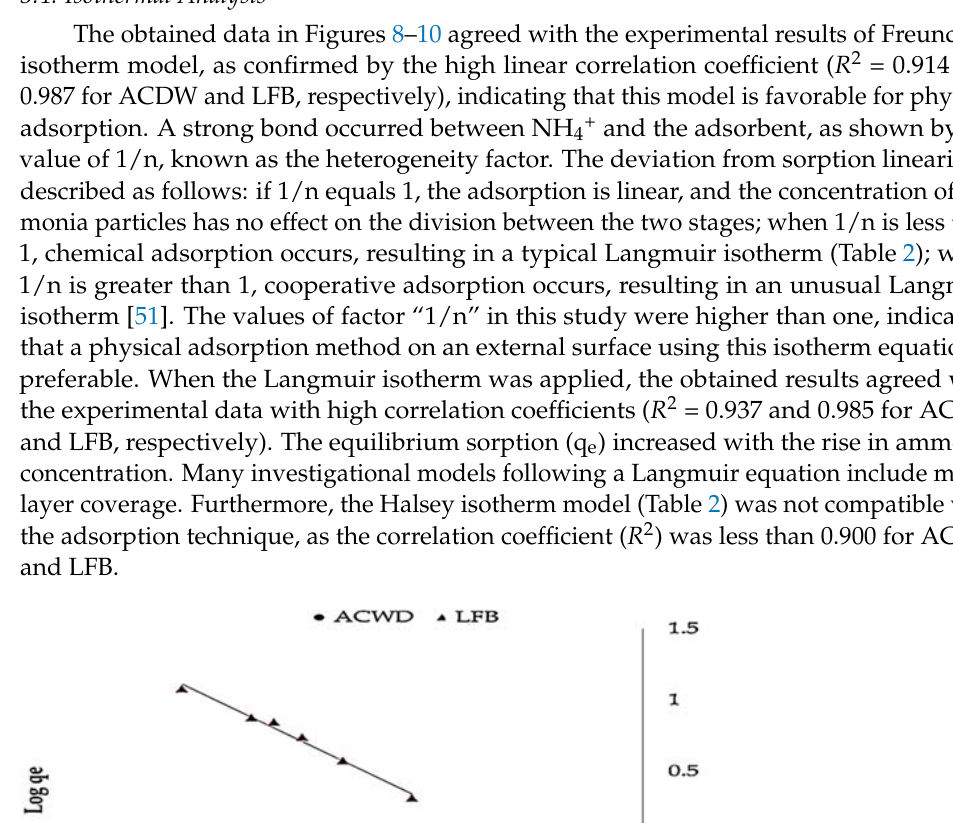
Figure 9. Langmuir isotherm plot for the sorption of ammonia using whole biomass (ACDW) and lipid ‐ free biomass (LFB) of Arthrospira platensis. Figure 10. Halsey model plot for the sorption of ammonia using whole biomass (ACDW) and li ‐ pid ‐ free biomass (LFB) of Arthrospira platensis. 3.5. Kinetic Analysis The kinetics of adsorbate uptake is critical for selecting the best operating conditions for design [49]. The kinetic data obtained from the adsorption of ammonium ions onto